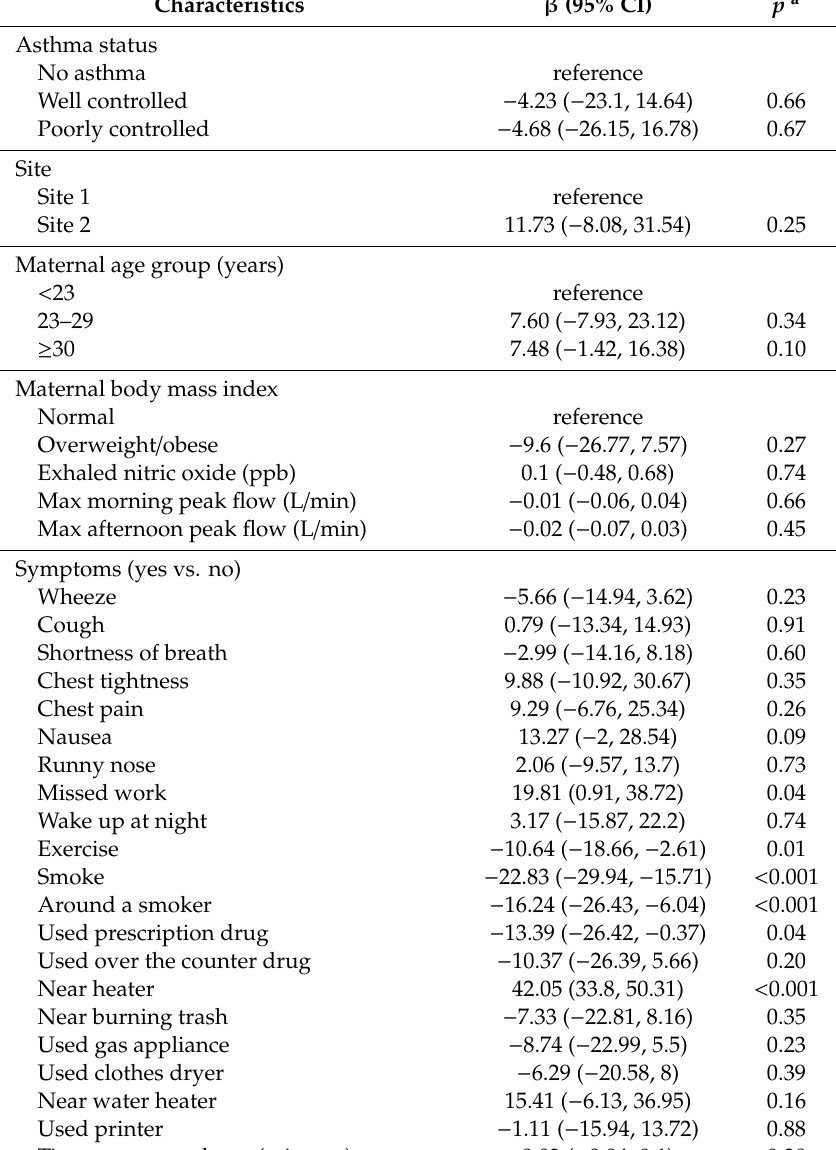
Table 4. Factors associated with compliance (proportion of waking-hour monitor-wearing